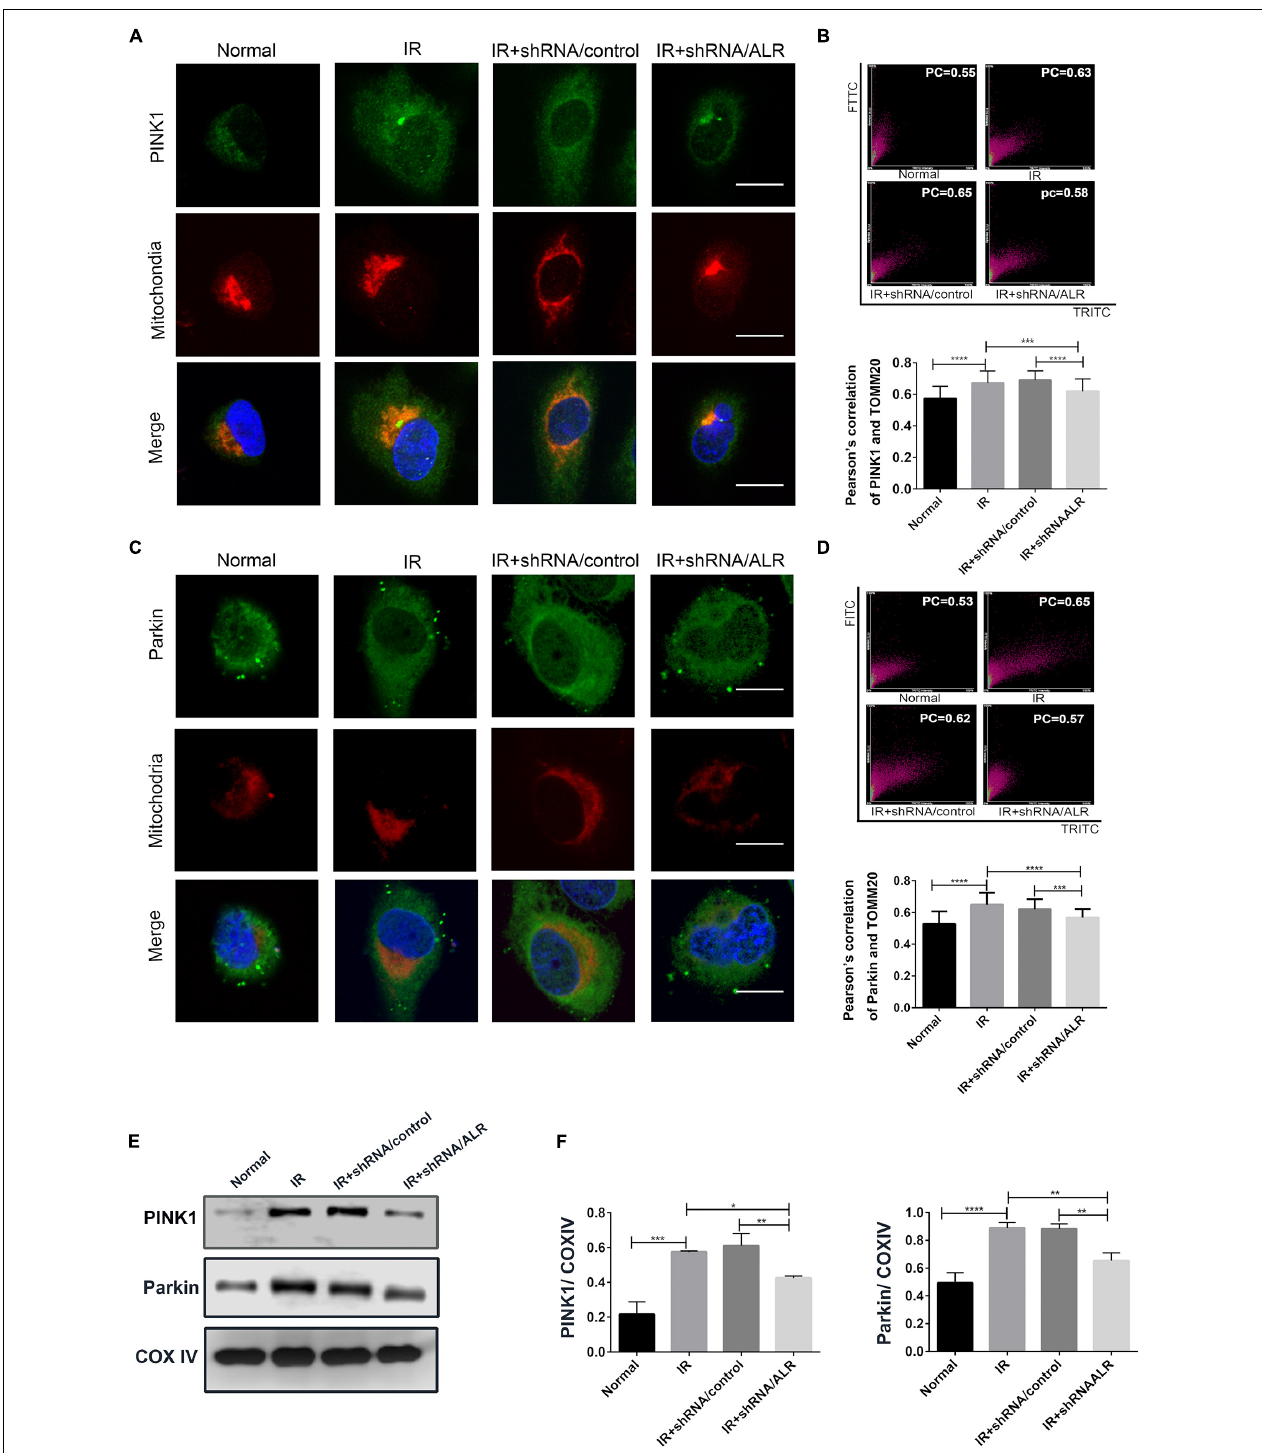
FIGURE 5 | Silencing of augmenter of liver regeneration (ALR) inhibited the activation of PINK1/Parkin pathway in HK-2 cells during ischemia–reperfusion (I/R). (A–D) Representative images and quantification of immunofluorescence double-labeling PINK1/Parkin and mitochondrial marker [translocase of outer mitochondrial membrane 20 (TOMM20)]. PINK1 or Parkin was labeled with fluorescein isothiocyanate (FITC) (green), mitochondria was labeled with tetramethylrhodamine isothiocyanate (TRITC) (red). Scale bar = 50 µ m. the Pearson’s correlation columns were shown in bar graph format. Sixty cells from three independent experiments were analyzed. (E,F) Immunoblot analysis and quantification of PINK1 and Parkin. Data represent means ± SD. n = 3. * p < 0.05, ** p < 0.01, *** p < 0.001, **** p < 0.0001.